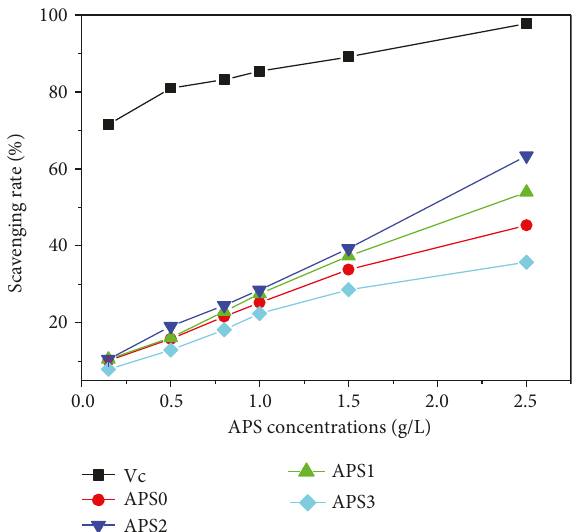
Figure 6: Reducing power of APS with di ff erent molecular weights.